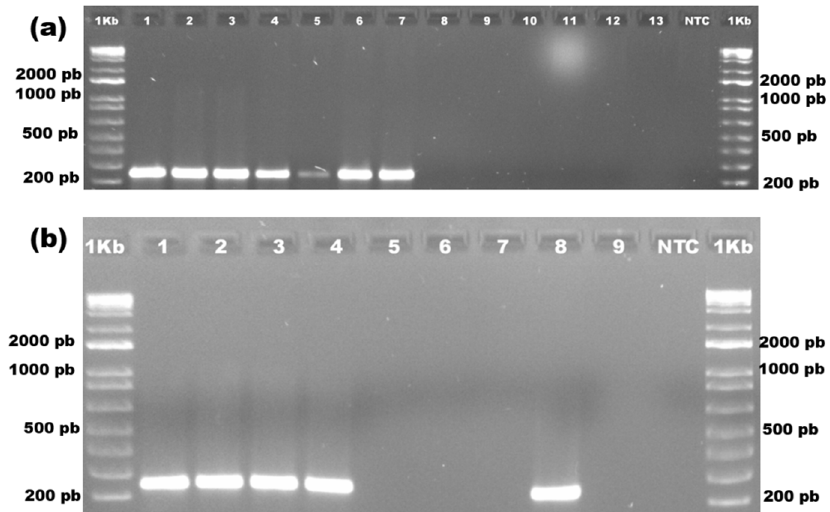
Figure 5. Specificity of PCR with the primer set KZ-AQ-3F/KZ-AQ-3R. ( a ) The 1 Kb lanes are for the DNA marker (1 Kb DNA ladder); positive bands at 241 bp; lane 1: krt-2 isolate; lane 2: krt-8 isolate;